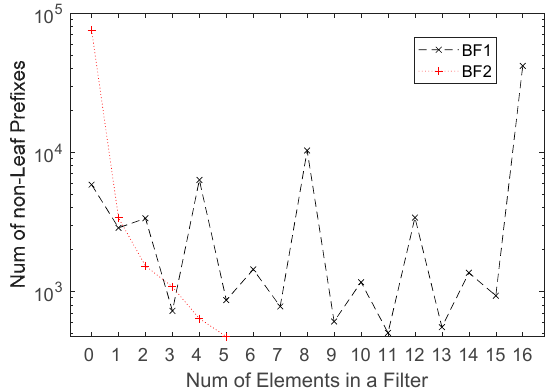
Figure 12. The number of non-leaf prefixes with a BF 1 size m 1 in log scale.